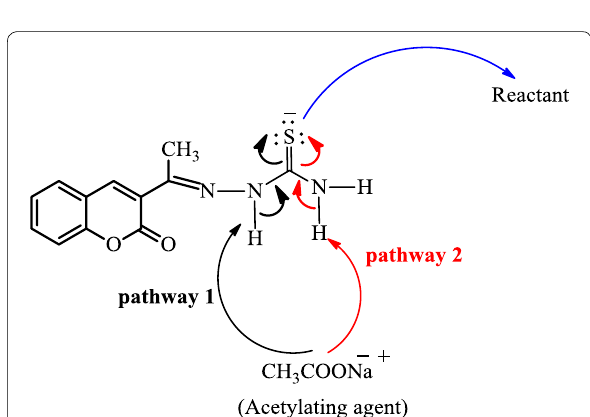
Fig. 2 Acetylation possibilities of thiosemicarbazone moiety based on HSAB